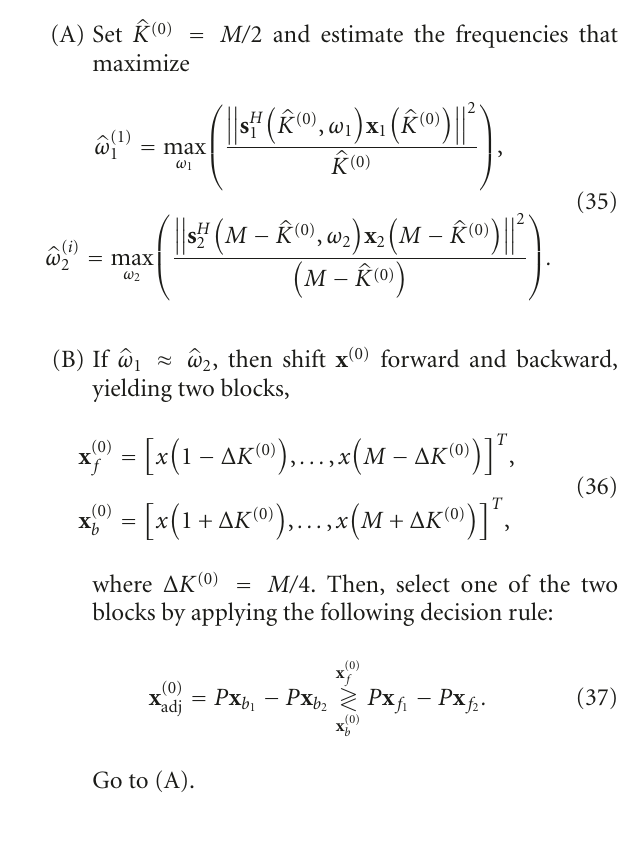
Algorithm Summary. The steps in the proposed algorithm are summarized as